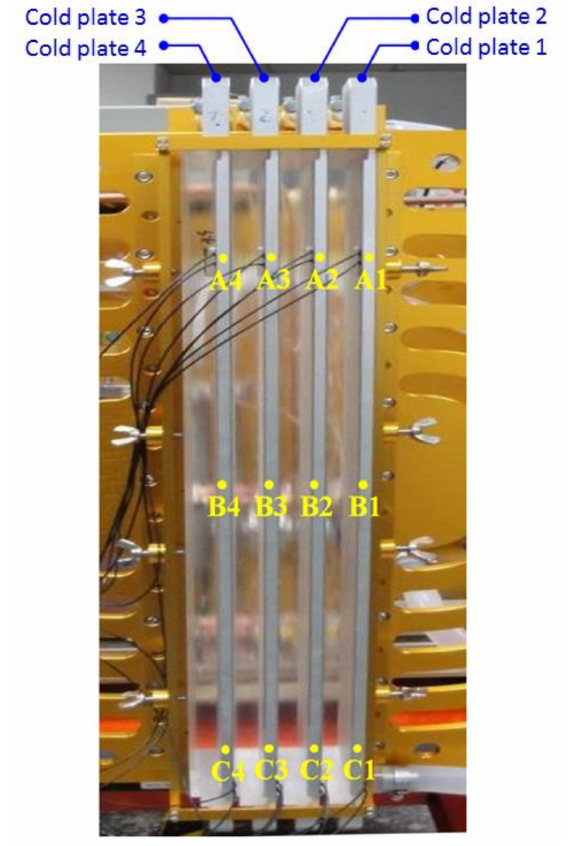
Figure 14. Location of the temperature measuring